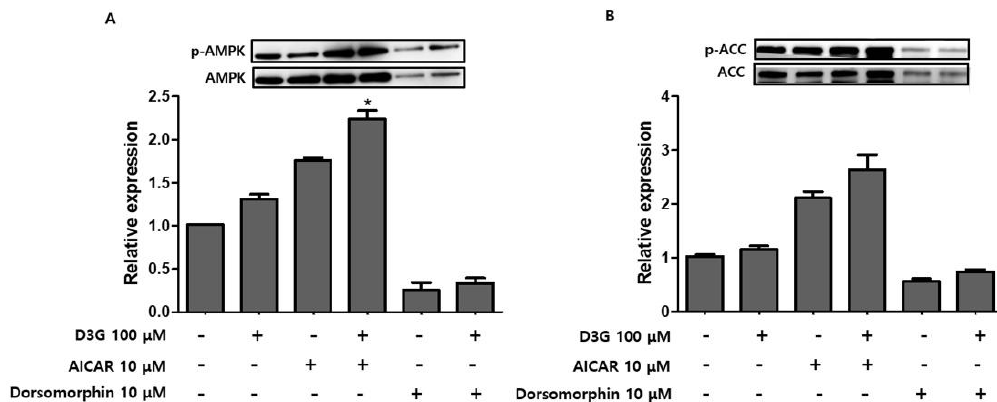
Figure 7. Effect of D3G on adenosine monophosphate-activated protein kinase (AMPK) activation in AMPK activator-treated and inhibitor-treated primary white adipocytes (PWATs). (A) p-AMPK/AMPK and (B) p-acetyl-CoA carboxylase (ACC)/ACC protein expression following D3G treatment in the presence of 5-aminoimidazole-4-carboxamide ribonucleotide (AICAR; 10 µM) and dorsomorphin (10 µM) in PWATs. Protein expression levels were measured by Western blotting. Each experiment was repeated three times and data represented the mean ± SD.